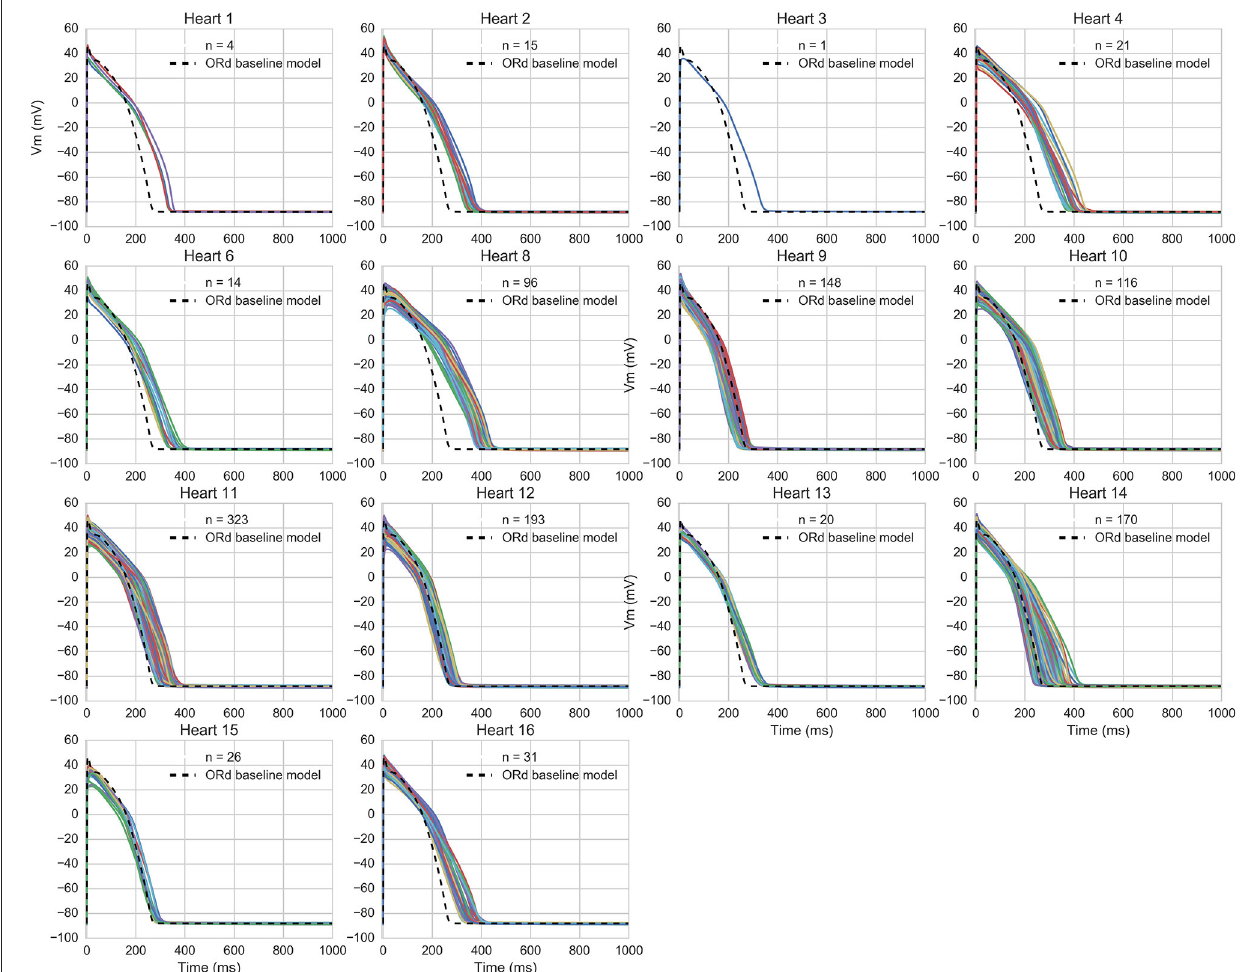
FIGURE 3 | AP traces of models in each heart-specific population of models. AP traces for each heart-specific population of models, and trace from the ORd baseline model for reference. 2/16 hearts did not have any of the 20,000 candidate models in range for all biomarkers and therefore had no accepted models, so are excluded from the figure. 860 out of the 20,000 candidate models were accepted into at least one